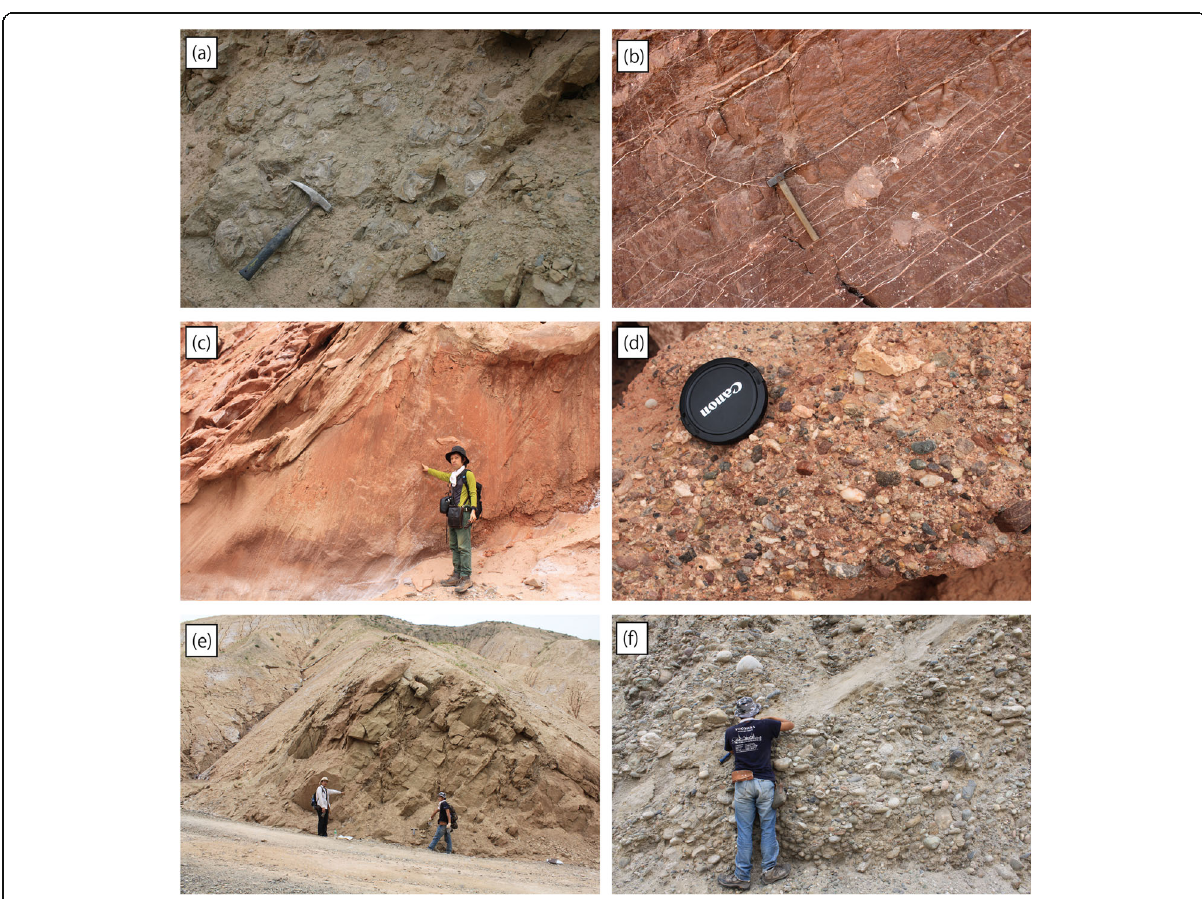
Fig. 2 Photographs showing the typical lithology of each formation. a Green mudstone with shell fossils of the Wulagen Formation. The shell height is ~ 0.3 m. b Reddish-brown mudstone containing gypsum veins of the Bashibulake Formation. Chicken-wire nodules of gypsum are also found in mudstones. c Aeolian sandstone showing high-angle cross-beddings at the bottom of the Wuqia Group. d Conglomerate of the lower part of the Artux Formation. The conglomerate is matrix-supported by fine sandstone and pebbles are sub-rounded to sub-angular and poorly- sorted. e Alteration of orange and yellow fine sandstone of the upper part of the Artux Formation. f Thick conglomerate and intercalated light yellowish gray fine sandstone of the Xiyu Formation. The conglomerate comprises pebbles to cobbles of various rock types including basement rocks and volcanic